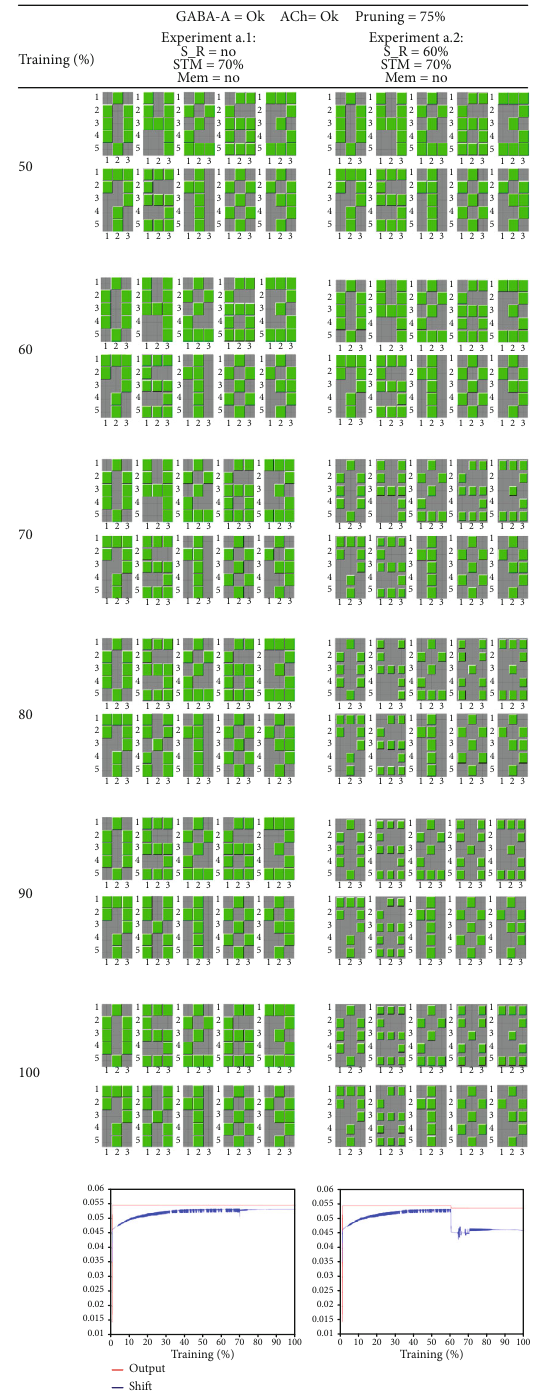
Figure 6: Normal aging. The two columns of this table show the koniocortex model behavior while performing a short-term memory (STM) task consisting of substituting one of the numerical patterns by pattern X. This substitution starts at 70% of epochs. In both experiments, the levels of GABA-A and ACh levels are normal, and pruning is also normal (starting at 75% of epochs). “ Mem =no ” means that in these experiments, we did not simulate the introduction of an NMDA blocker (memantine). At the bottom of each column, we show the evolution of the average output (in red) and average shift (in blue) of all neurons. Experiment a.1: the label “ S_R =no ” at the header of the fi rst column means that there is no reduction of stimuli in this experiment. As seen in the block corresponding to 80% of training, the network successfully learns pattern X. Experiment a.2: the label “ S R = 60 % ” at the header of the second column indicates that there was a reduction of stimuli at 60% of repetitions. From this point, the average output and average shift experiment a sudden fall but stabilize rapidly. The presentation of a new pattern X at 70% of epochs does not alter the ongoing network dynamics in any signi fi cant way. Labels: S_ R =sensory reduction;STM =short-termmemory; Mem =memantineapplication; ACh =acetylcholinereduction in